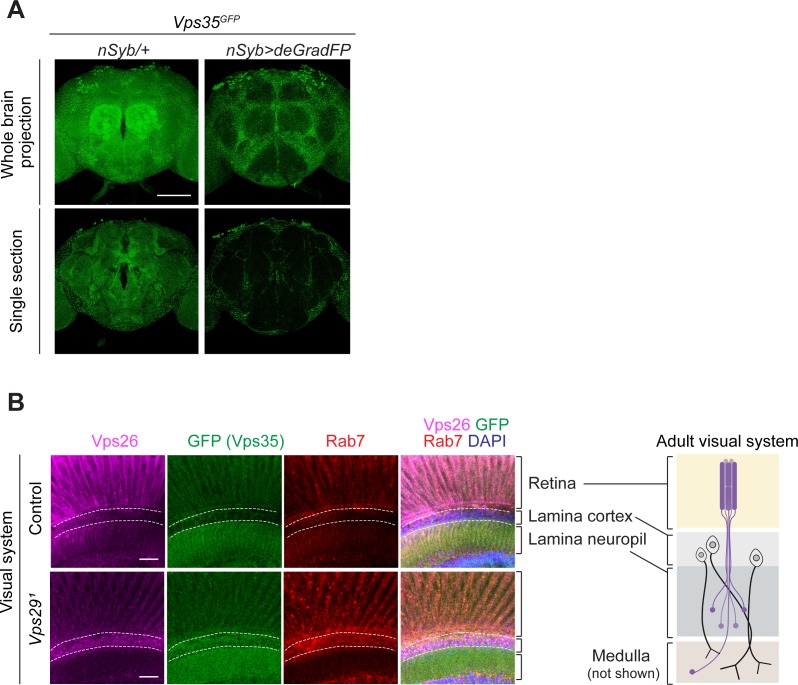
Loss of Vps29 causes mislocalization of retromer in adult brain.(A) Neuronal expression of Vps35 (anti-GFP) in the adult fly brain was examined by selective depletion using deGradFP. The following genotypes were examined: Vps35GFP; nSyb-Gal4/UAS-deGradFP (also known as Nslmb-vhhGFP4) and Vps35GFP; nSyb-Gal4/+. Crosses were established and maintained at 18°C, and adult animals were shifted to 29°C for 7 days post-eclosion, prior to brain dissection. Scale bars, 100 µm. (B) In the adult retina of Vps29 mutants, Vps35 (anti-GFP, green), Vps26 (anti-Vps26, magenta), and Rab7 (anti-Rab7, red) are increased in the cortex of the lamina where neuronal cell bodies (marked by DAPI) are concentrated. The following genotypes were examined: Vps291, Vps35GFP homozygotes and Vps35GFP (control). Scale bars, 20 µm.